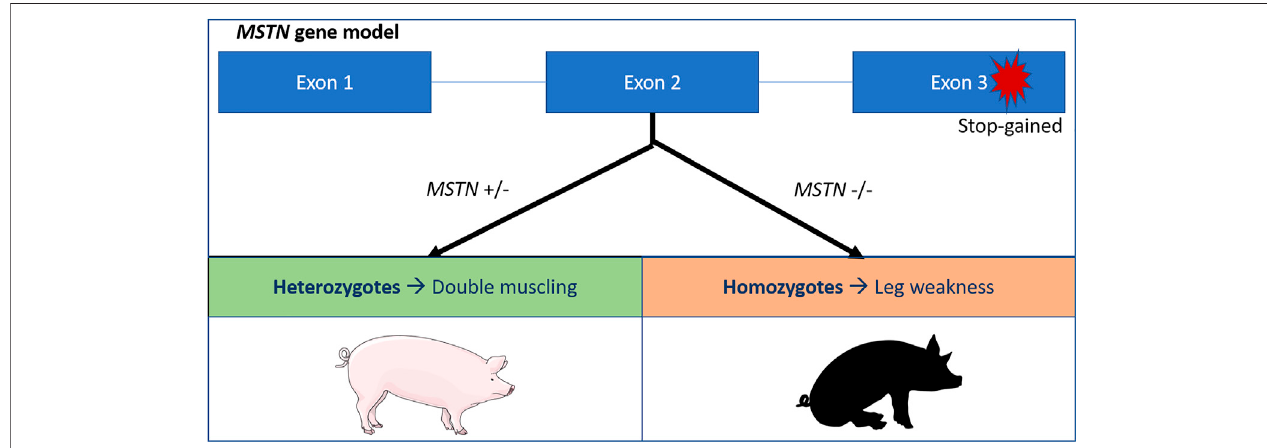
FIGURE1| Schematicoverviewofthe MSTN stopgainedvariantinpigs(Matikaetal.,2019).Thestopcodonaffectsthethirdexonofthe MSTN gene,leadingtoa premature stop codon and a loss of function of the myostatin protein. Heterozygotes exhibit the double muscling phenotypes, while homozygotes suffer from leg